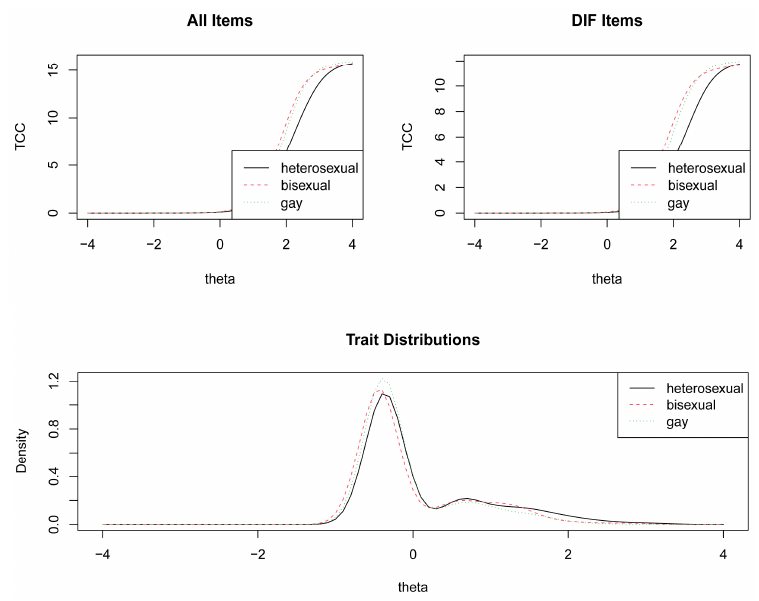
Figure 1. DIF of NATMI for sexual orientation. Table 5. Differential item functioning: probabilities ( p ) associated with the models (M) of the regression and effect